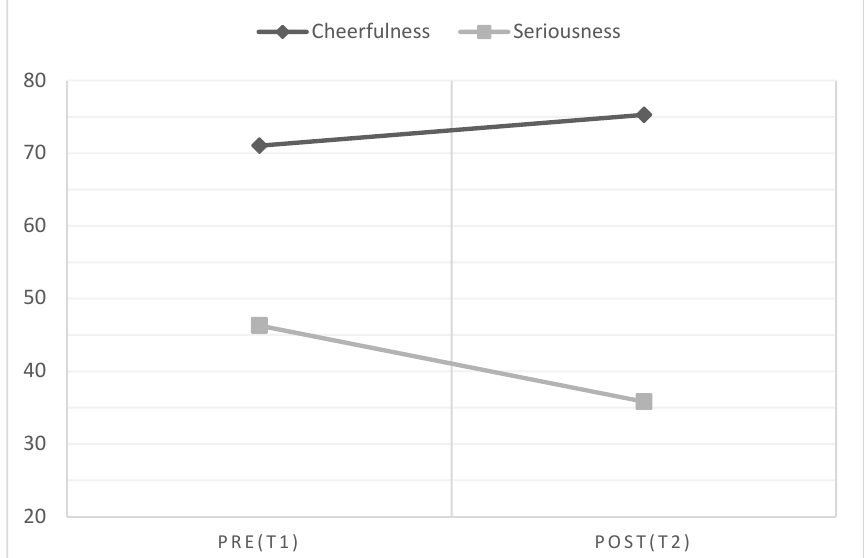
Figure 1. Cheerfulness and seriousness scores both before and after training (N = 58). For clarity, the Y -axis shows mean scores (not mean ranks).